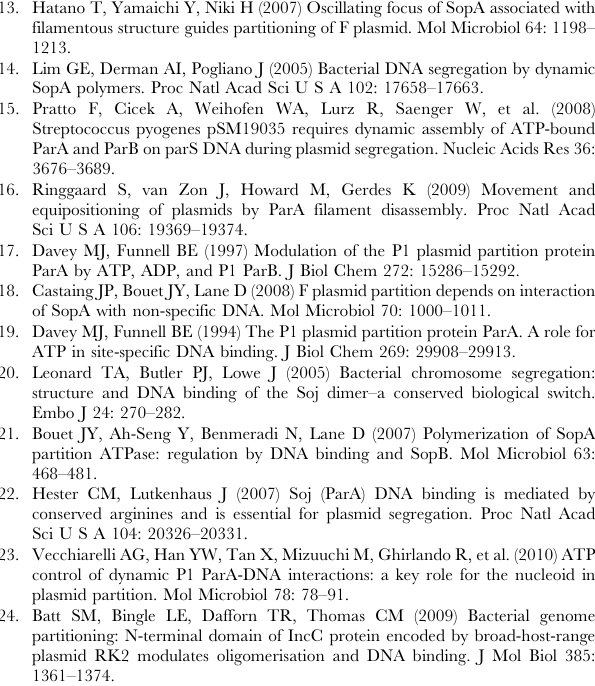
cells expressing the wt and R36A sopB alleles. * denotes data